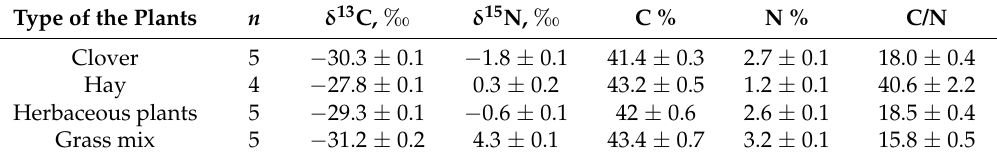
Table A2. Stable isotope ratio values and elemental data for the cow